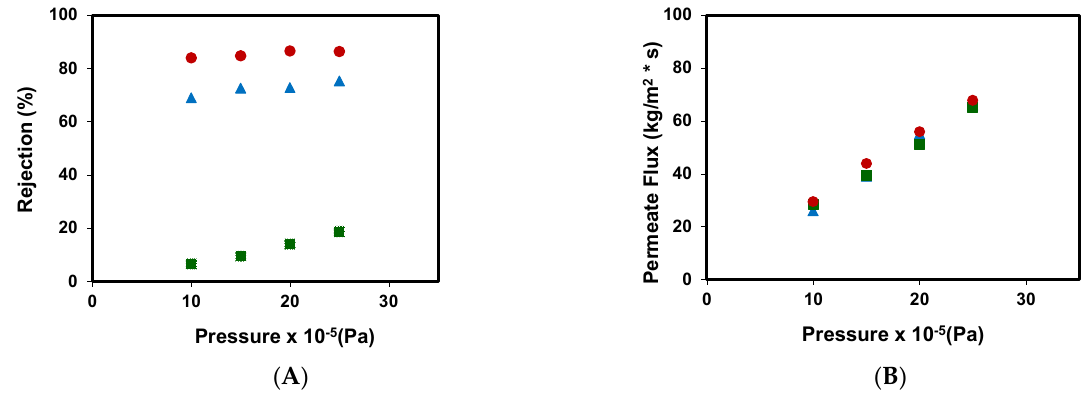
Figure 2. ( A ) Rejection coefficients and ( B ) permeate fluxes obtained with the NF99 membrane at different pressures for the different emerging pollutants assayed: ( ■ ) methyl paraben, ( ● ) caffeine, and ( ) metformin.